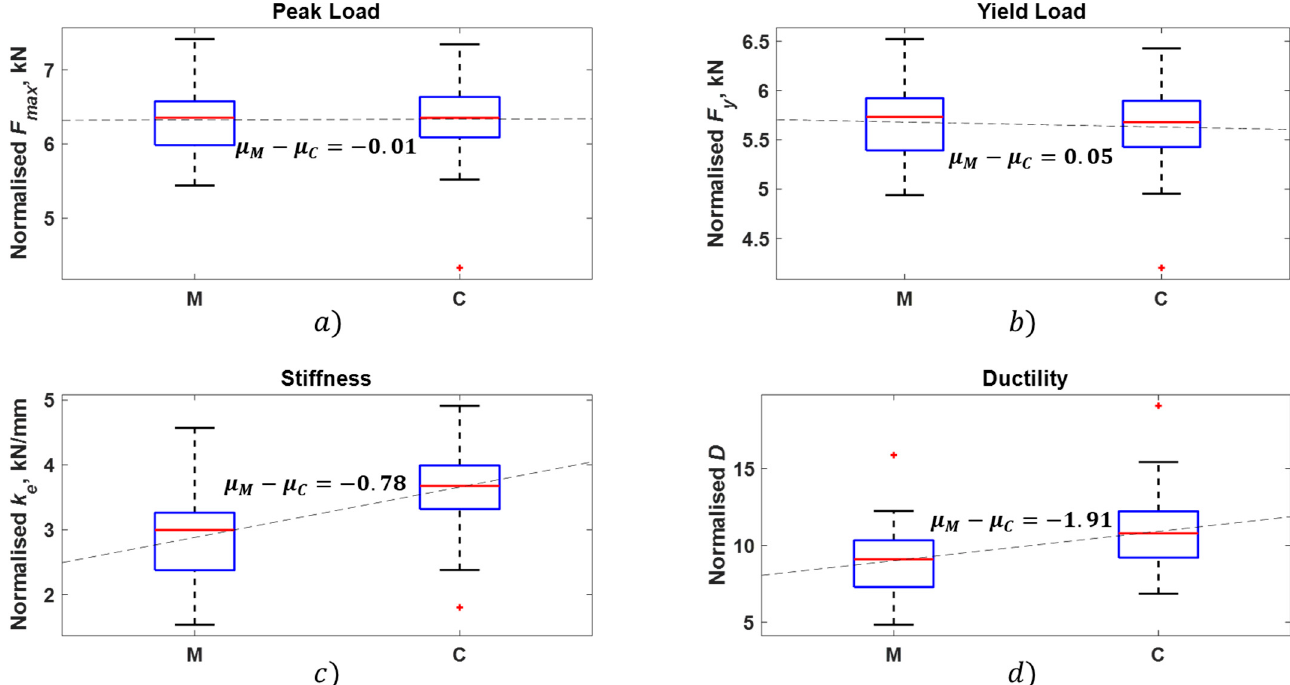
and OSB sheathing only) by normalised ( a ) peak load, ( b ) yield load, ( c ) stiffness, and ( d ) ductility.